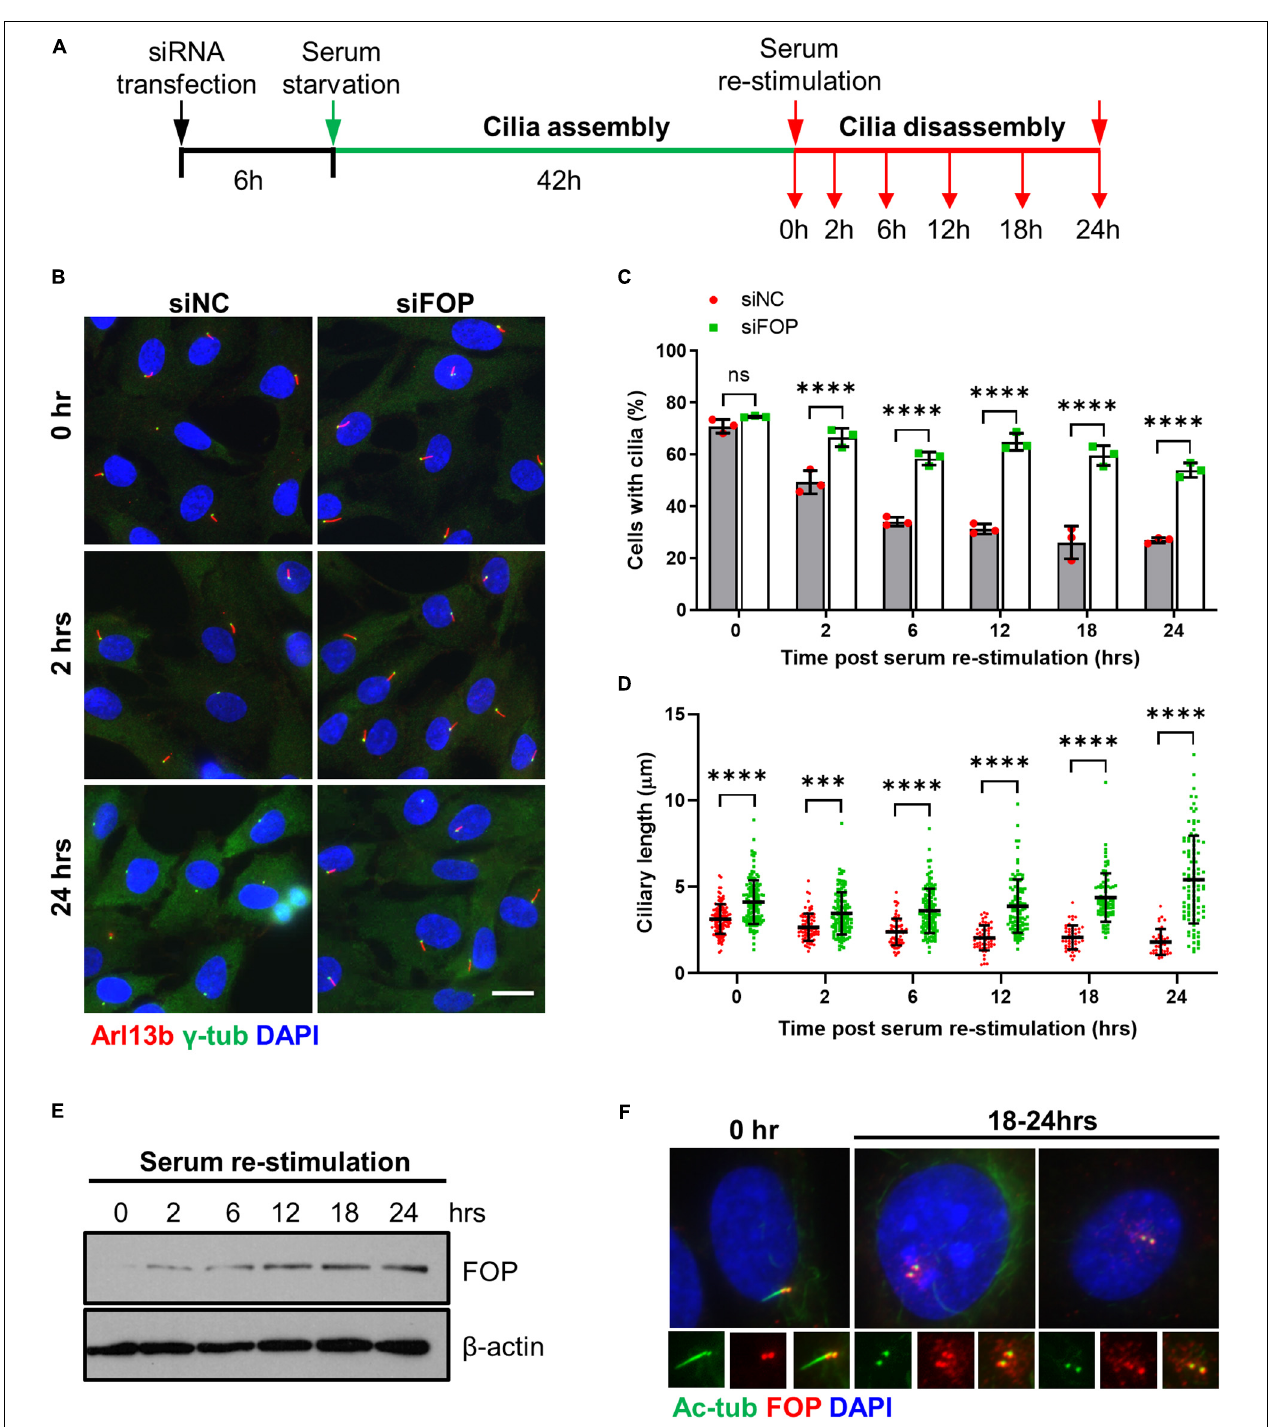
FIGURE 3 | FOP is required for timely cilia disassembly. (A) Schematic diagram of experimental design for cilia disassembly assay. RPE1 cells transfected with siNC or FOP siRNAs were serum-starved for 48 h, followed by serum re-stimulation and fixation at different time points as indicated. (B) Fixed cells were immunostained for Arl13b (red) and γ -tubulin ( γ -Tub; green). Representative images are shown for the 0, 2 h, and 24 h samples. The nuclei were stained with DAPI. Scale bar, 20 µ m. (C) Quantification of the percentage of ciliated cells described in (A) . At least 200 cells per sample were analyzed in each experiment. (D) Quantification of ciliary length described in (A) . From left to right, the cilia number n = 112, 133; 75, 128; 74, 126; 54, 103; 47, 81; 38, 98. Data are presented as mean ± SD from three independent experiments; ns, not significant; *** p < 0.001; **** p < 0.0001 (Two-way ANOVA followed by Tukey’s multiple comparisons test). (E) Immunoblotting analysis of FOP expression during cilia disassembly. (F) RPE1 cells were immunostained for acetylated α -tubulin (Ac-Tub; green) and FOP (red). The nuclei were stained with DAPI. Scale bar, 20 µ m.